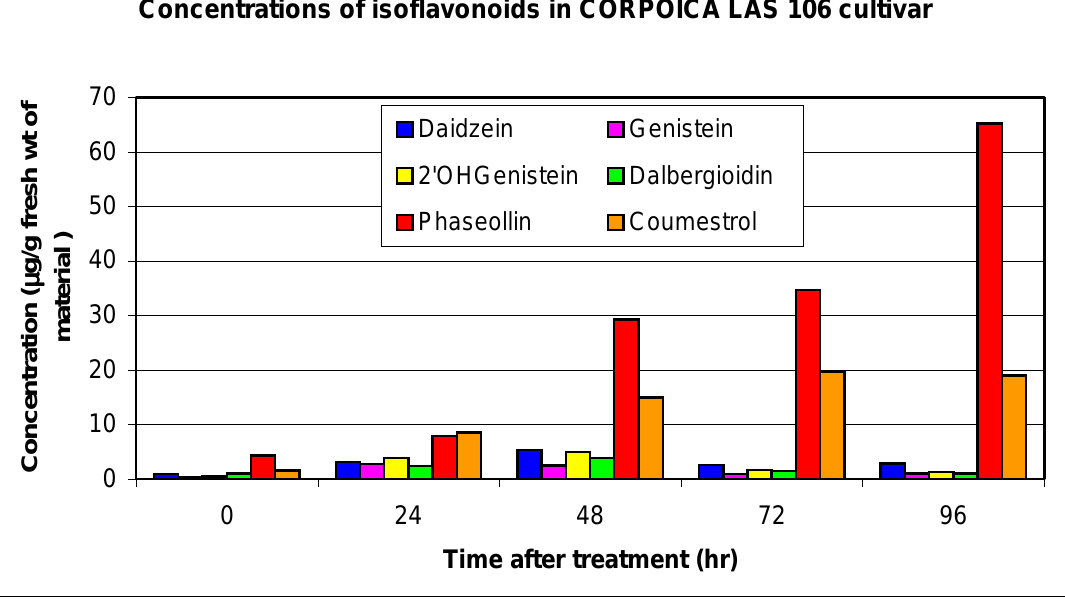
Concentrations of isoflavonoids in CORPOICA LAS 106